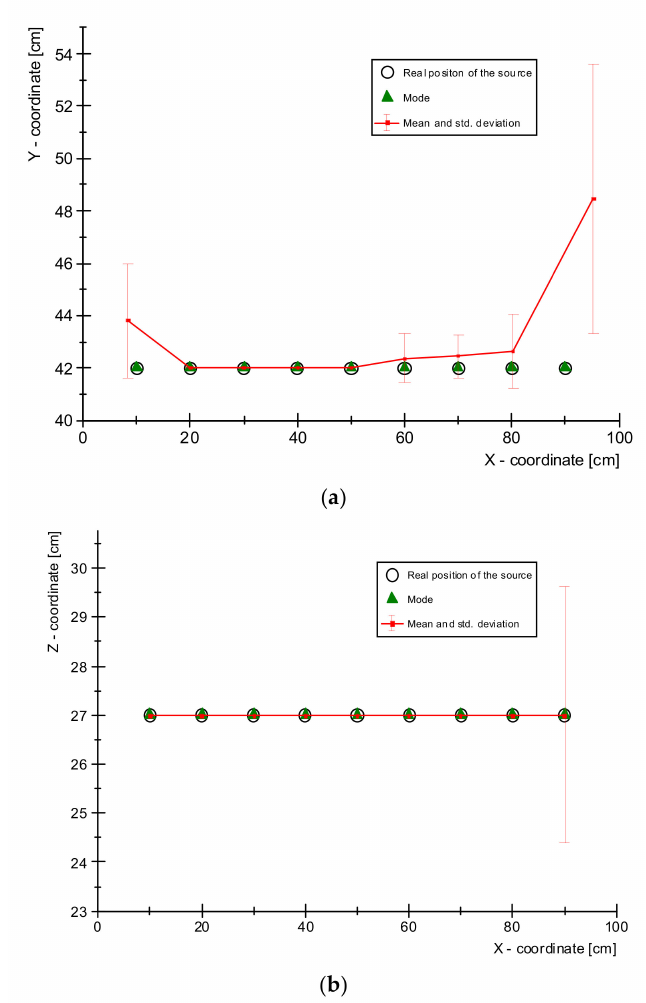
Figure 16. Analysis of errors in the calculated standard deviations of the location for each axis: actual position, detected position (mean) and errors (std. deviation), as well as detected position reducing the dispersion error (mode); ( a ) in the Y axis, and ( b ) in the Z